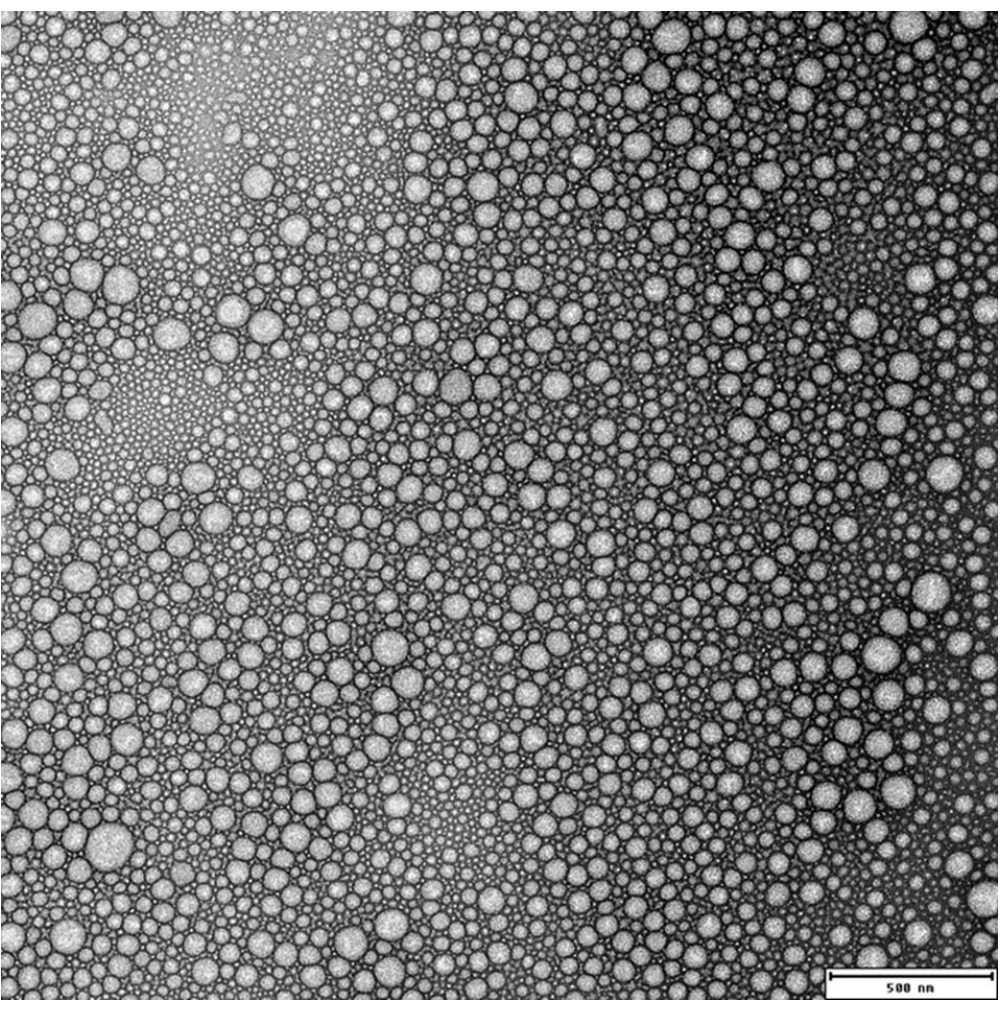
Figure 2. Transmission electron micrographs image of NH 2 -PEO-PCL nanoparticles (bar 500 nm). PDI is an indicative of the NPs size distribution, ranging from 0 to 1, and defines the dispersion homogeneity. Values close to 1 indicate heterogeneity and PDI values lower than 0.5 indicate NPs of better quality with a homogenous distribution of particle size [33,34]. All the NPs showed unimodal distribution, as indicated with PDI values of less than 0.35, suggesting a homogenous distribution under the preparation conditions.